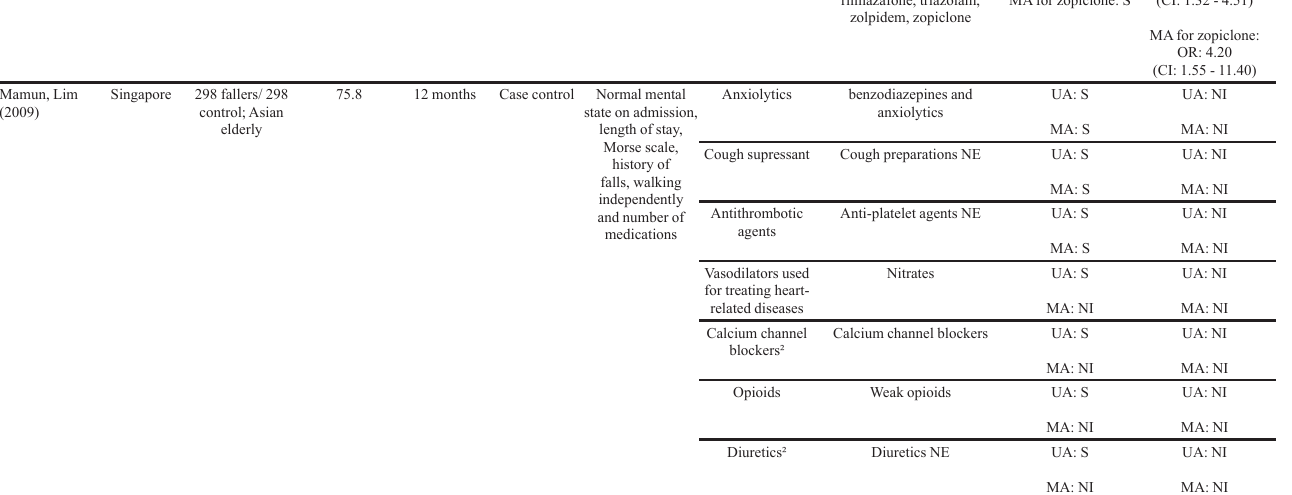
Hypnotics and sedatives